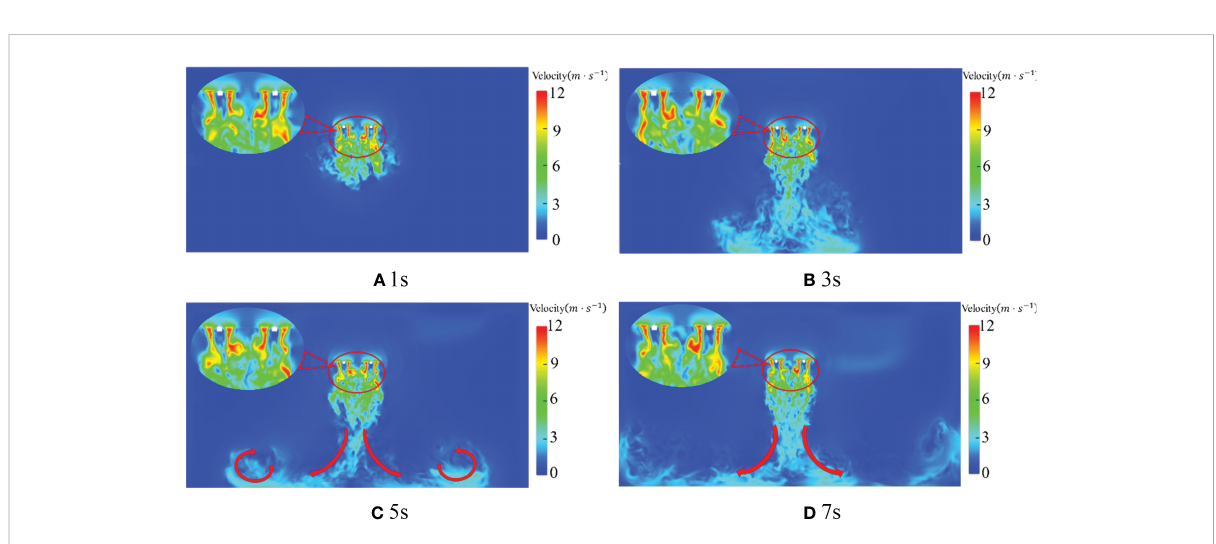
FIGURE 9 Rotor velocity distribution at a different time and